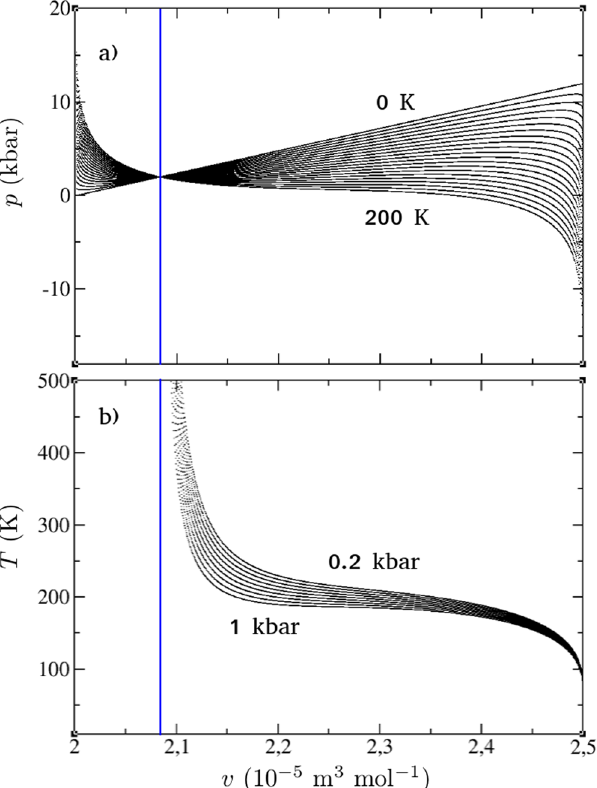
Figure 2. ( a ) Pressure ( p ) versus volume ( v ) phase diagram obtained from Eq. (3) for different values of temperature. The temperature was uniformly varied from 0 to 200 K, with steps of 10 K. The straight line is related to T = 0 K. Similar results were reported in ref. 12 . ( b ) Temperature ( T ) versus volume ( v ) for different values of pressure, which were also varied uniformly as in panel (a). The parameters used were the same as in 12 , 5 3 1 , δ = . × − − v (0 5 10 ) m mol 5 3 1 and λ = . 0 2 . The namely = c 6 , δε = − 1000 J mol 1 , = × − − v (2 10 ) m mol 0 blue solid line indicates the lower physically valid volume in our